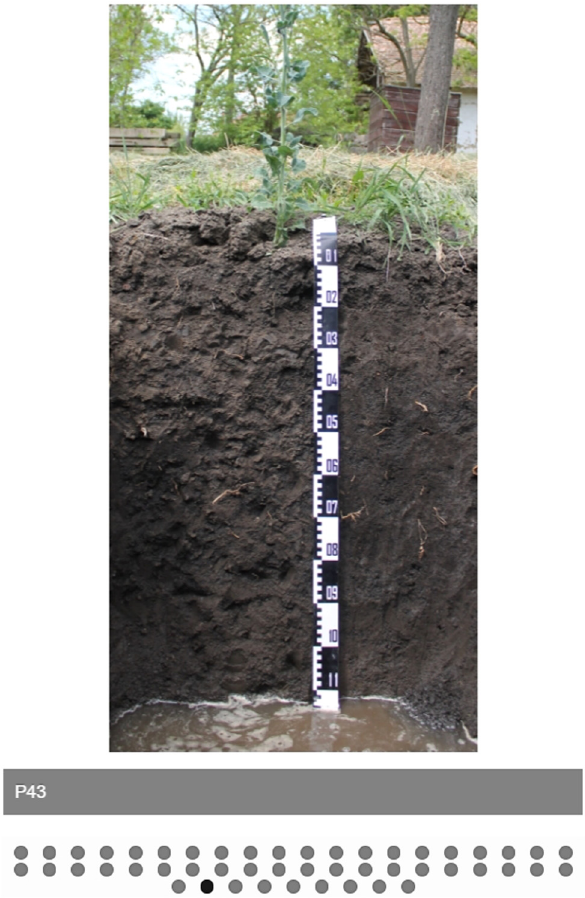
Figure 11: Interface of Gallery